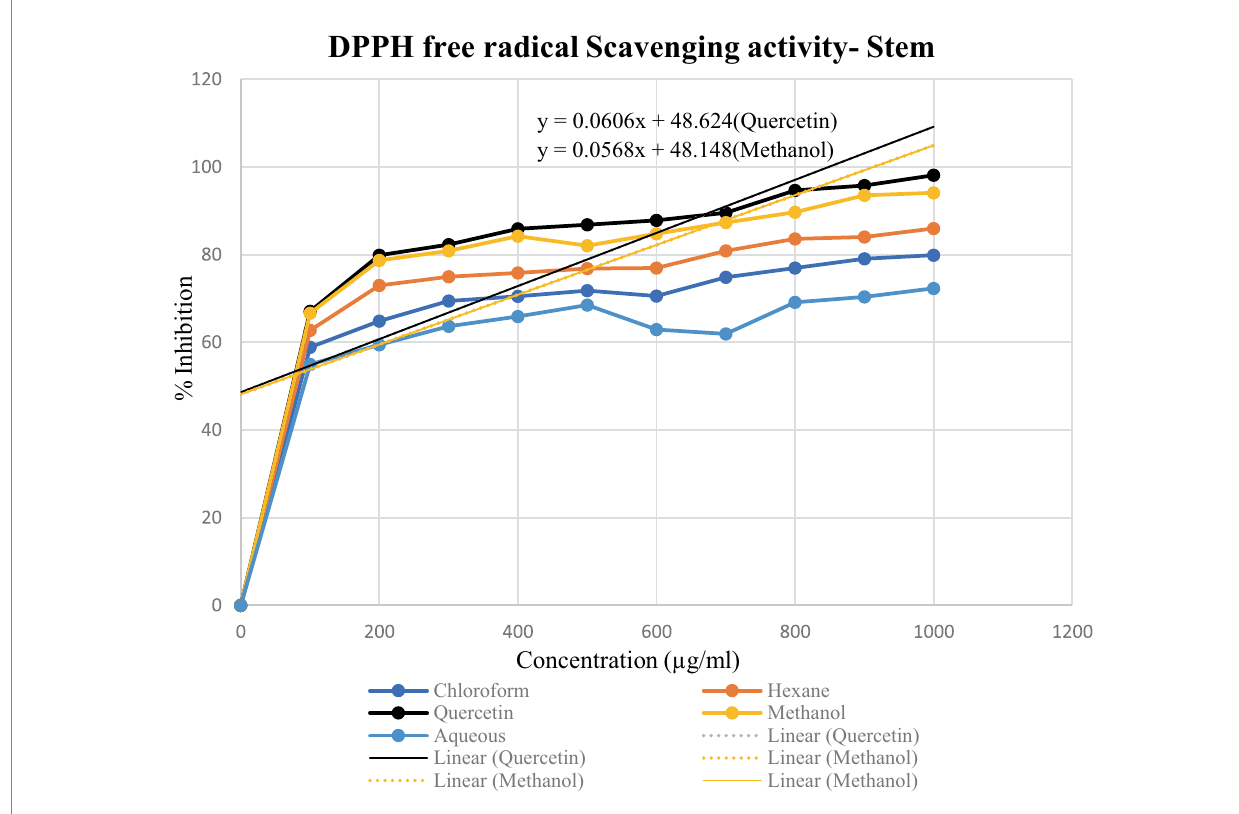
FIGURE 4 Graphical representation of the percentage of inhibition of hexane, chloroform, methanol and aqueous extracts for T. cordifolia stem.